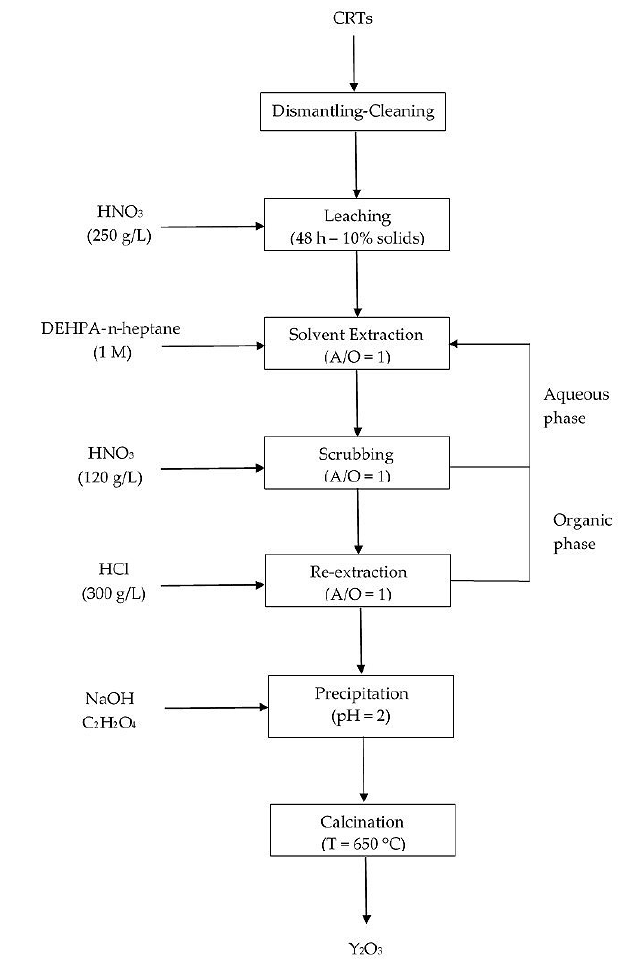
Figure 5. Process flow diagram for yttrium oxide recovery from CRT